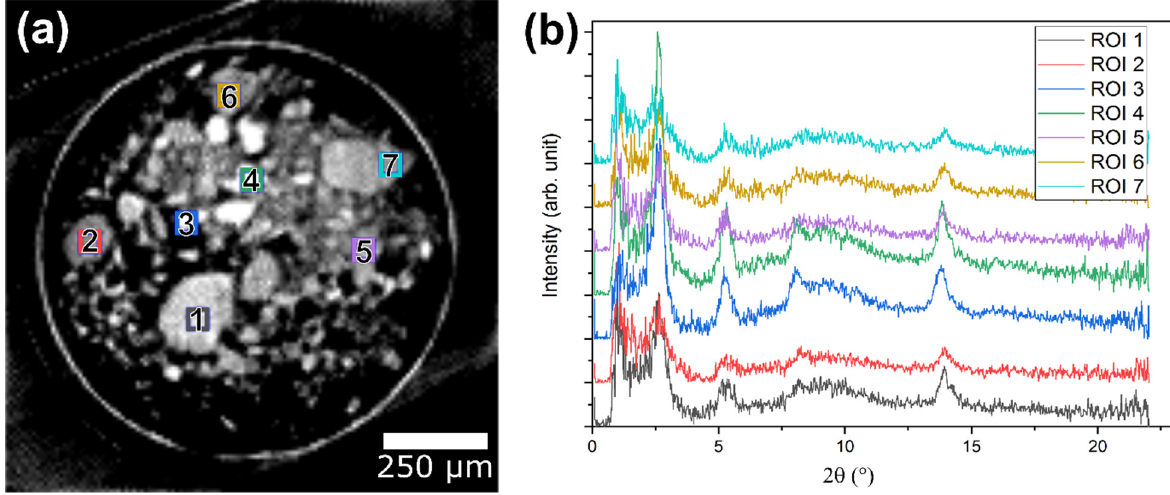
Figure 4. ( a ) Selected regions of interest from different particles of the catalyst bed from tomography data of the initial dry gel state. ( b ) XRD patterns represent the summed signal from all pixels within the regions of interest, indicating heterogeneity within the sample. XRD patterns recorded at λ = 0.0354 nm.